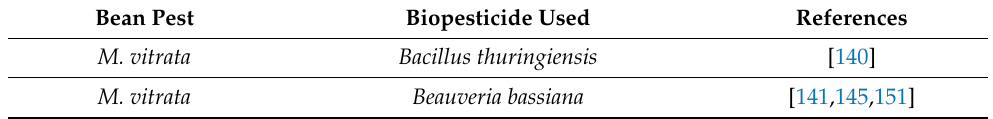
Table 5. Microbial biopesticides used in the control of Aphis fabae and Maruca vitrata . Bean Pest Biopesticide